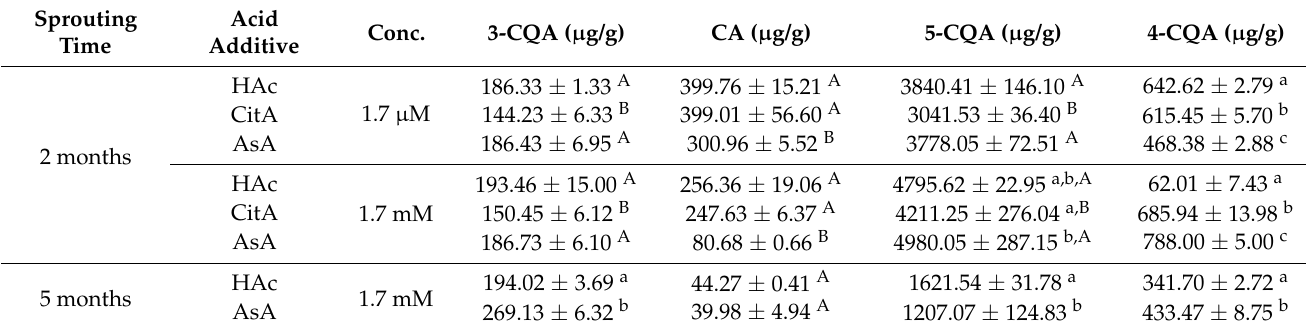
Table 6. Phenolic acid content ( µ g/g) in a freeze-dried sprout sample extracted with different acid additives at two different concentrations (1.7 µ M and 1.7 mM) (Stage-2 sprouts). The bottom row refers to freeze-dried Stage-3 sprouts (acid additive 1.7 mM). Results are expressed as mean value ± standard deviation ( n =